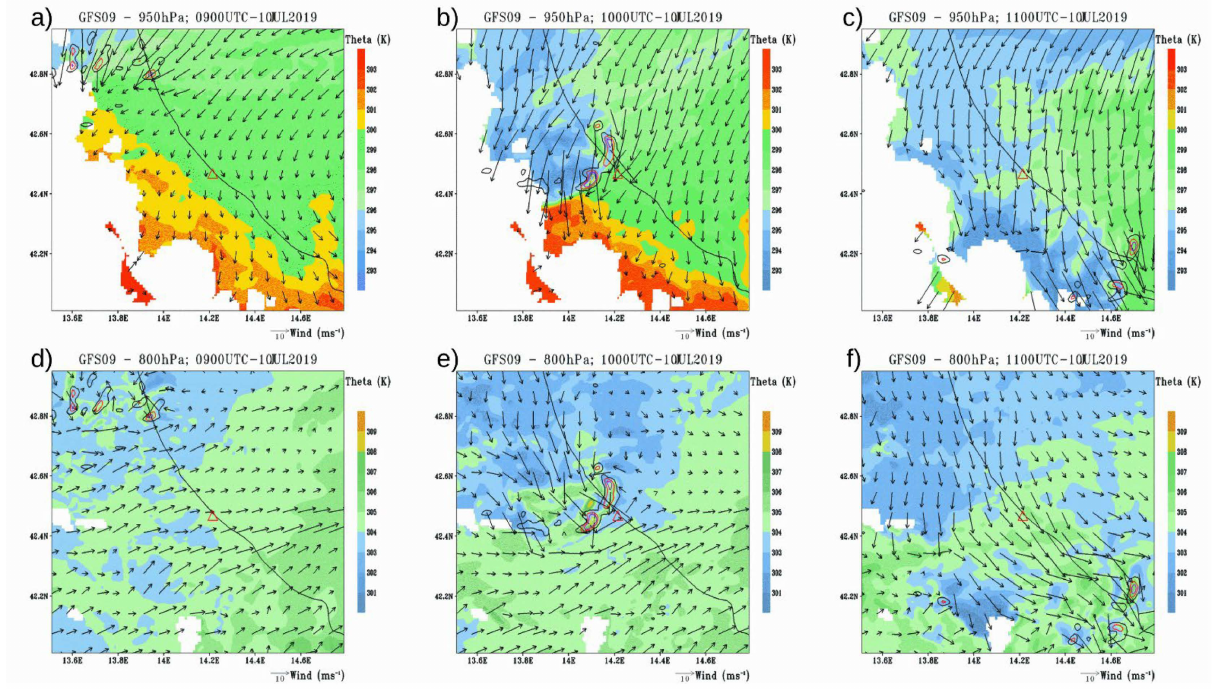
Figure 9. Run GFS09 at 08:00 UTC, 10 July 2019. Θ and wind vectors at 950 hPa at 09:00 ( a ), 10:00 ( b ), and 11:00 UTC ( c ); Θ and wind vectors at 800 hPa at 09:00 ( d ), 10:00 ( e ), and 11:00 UTC ( f ). In the maps, the contour lines near the convective system represent UH: contours in black, red, purple, and yellow correspond to 50, 250, 500, and 1000 m 2 s − 2 , respectively. The red triangle indicates the city of